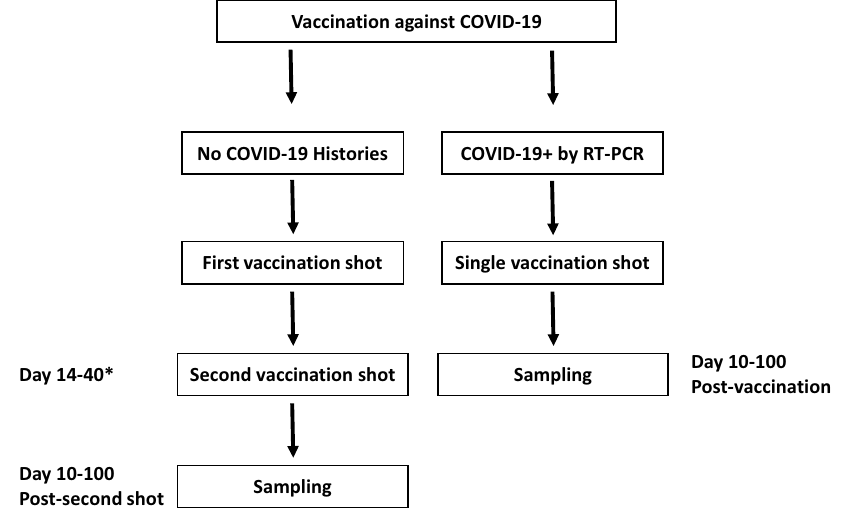
Figure 1. Flowchart for vaccination and sampling procedures. * Second shot, when applicable, was administered according to the manufacturer recommendations as mentioned in “Material and